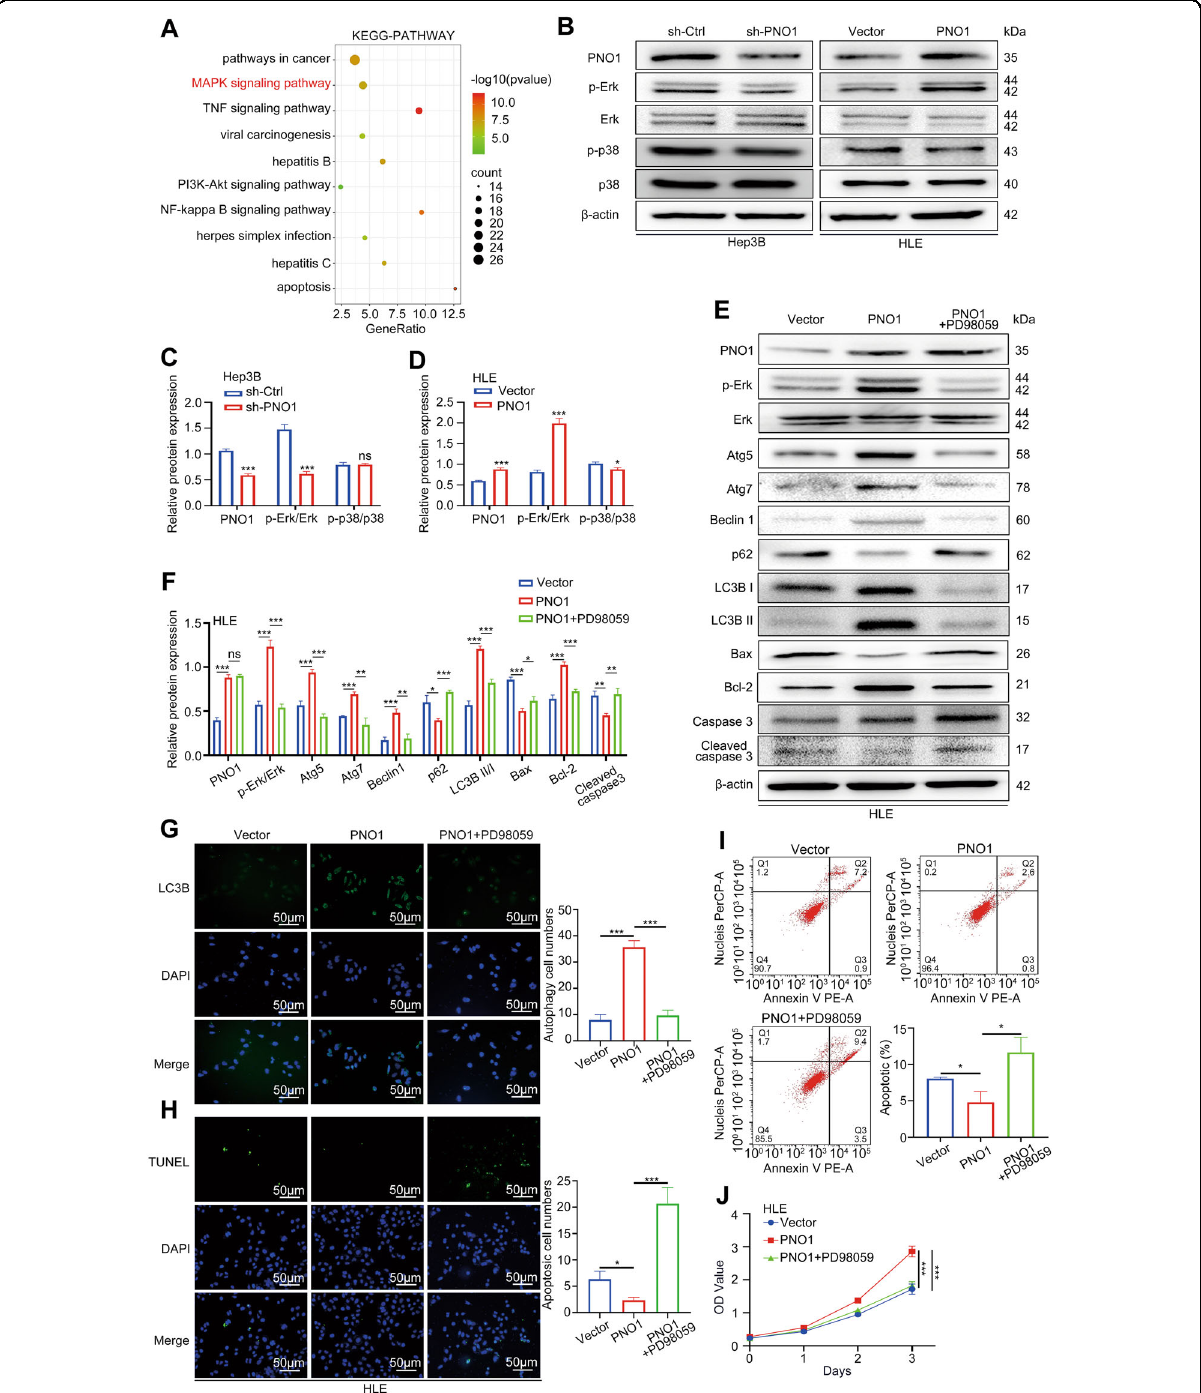
Fig. 4 PNO1 inhibits cell apoptosis by promoting autophagy through the MAPK signaling pathway in HCC. A Signal pathway enrichment analysis of sh-Ctrl and sh-PNO1 groups by RNA-seq in Hep3B cells. B The effect of the downregulation or upregulation of PNO1 expression on MAPK signaling pathway activation was veri fi ed by Western blotting in Hep3B and HLE cells. C , D Quanti fi cation of relative protein expression. E HLE PNO1 cells were pretreated with PD98059. Western blotting analysis of the protein levels of p-Erk, Erk, and apoptosis and autophagy-related protein. F Quanti fi cation of relative protein expression. G , H Cells as in ( E ) were immunostained with antibodies against LC3B ( G ) and TUNEL staining ( H ). Scale bar: 50 μ m. I Apoptotic rate was measured using annexin V/PI double staining in cells as in ( E ). J CCK-8 assay assessed the viability of cells as in ( C ). Data were presented as mean ± SEM. n = 3 – 4. * p < 0.05, ** p < 0.01, *** p <